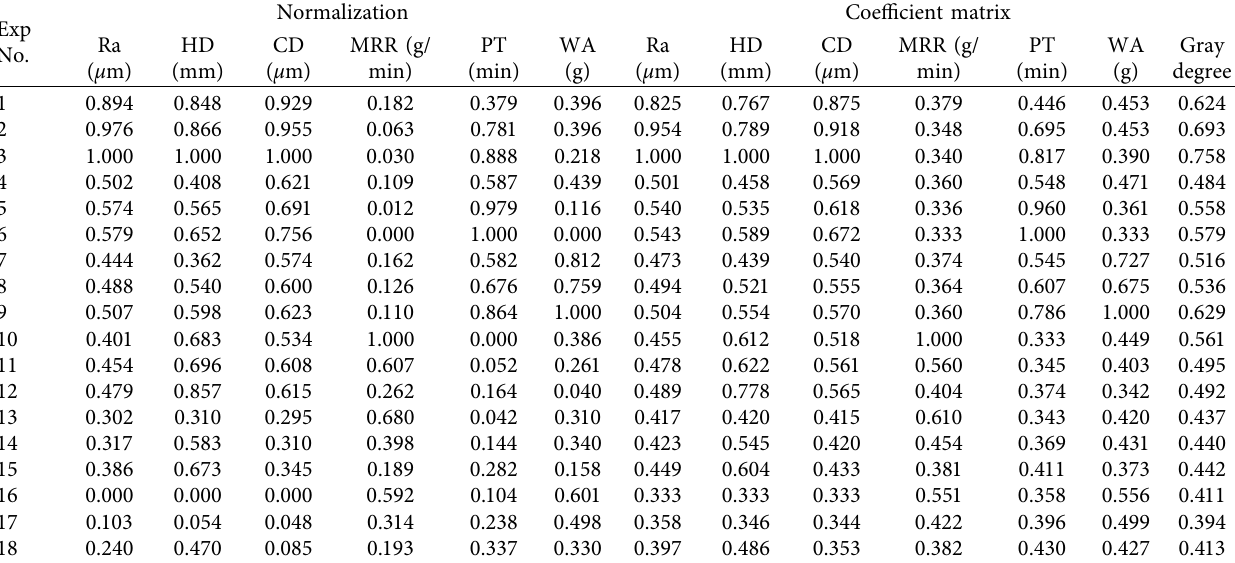
Table 7: Gray relational analysis and